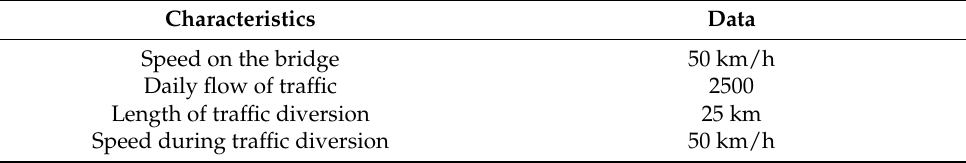
Table 4. Characteristics of the bridge considered for the deterministic